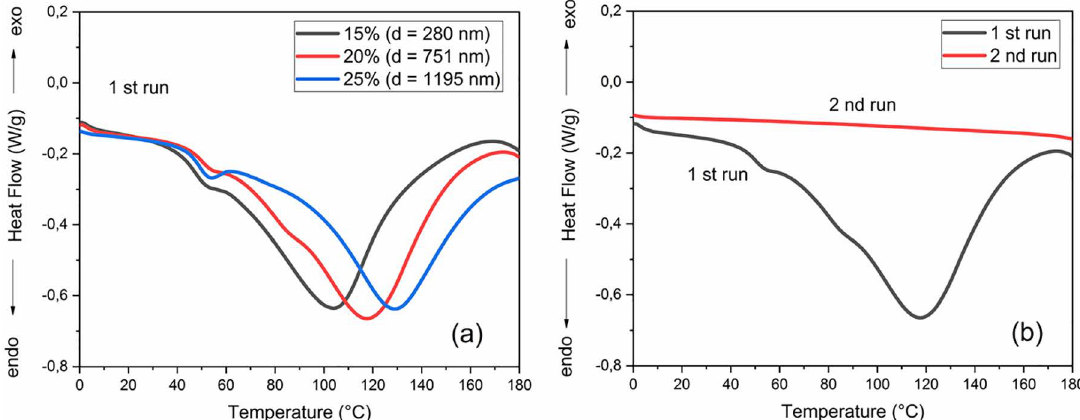
Figure 3. DSC thermograms of microfibrous mat of fish gelatin: (a) 1st heating run for all samples and (b) 1st and 2nd heating run of sample 20%